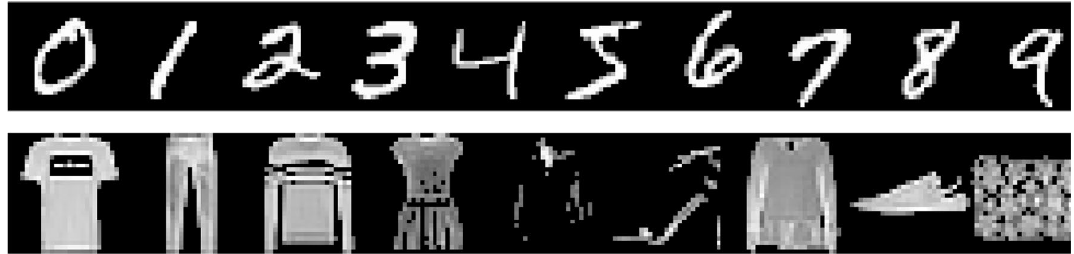
Figure 5. (Top) Several example images from MNIST database of handwritten digits. (Bottom) Several example images from MNIST-like fashion product database of Zalando’s article images designed as a direct drop-in replacement for the original MNIST dataset.